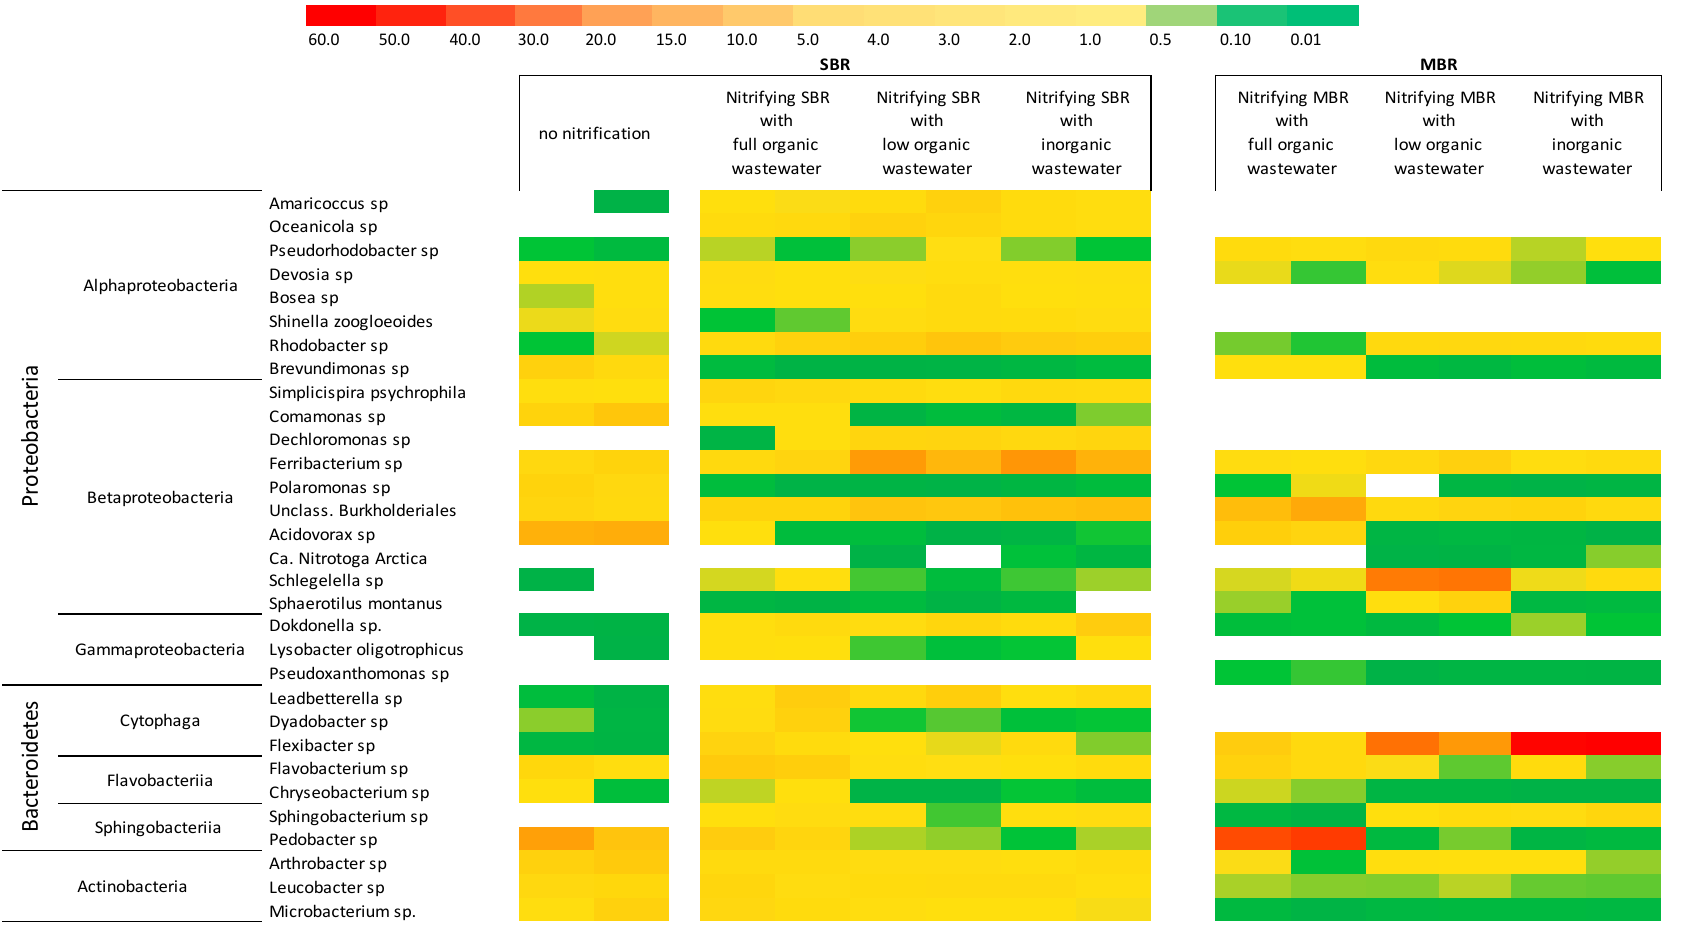
Figure 8. Dynamics of the most abundant bacterial genera in SBR and MBR pilot reactors before and after the change of carbon source in wastewater.